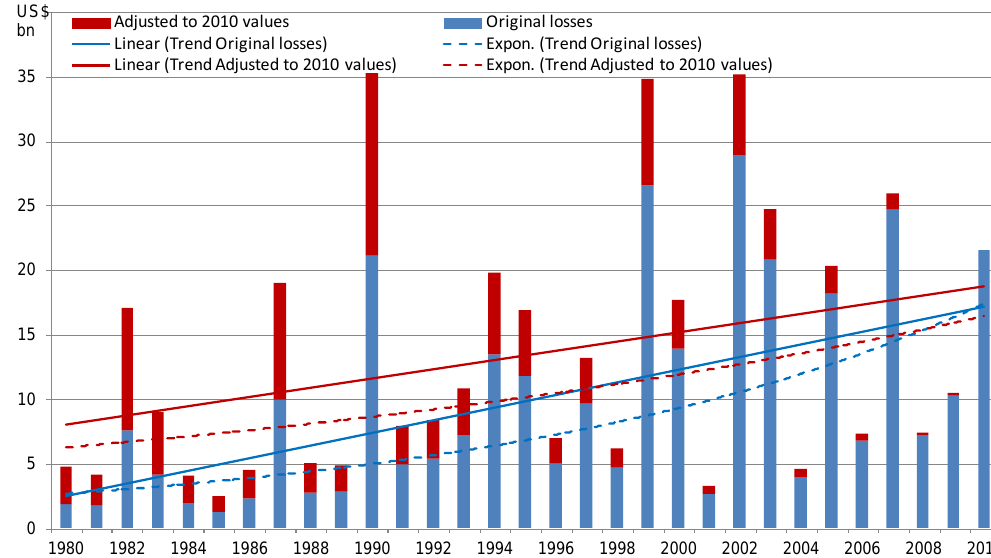
Fig. 4. Overall losses from weather disasters in Europe (1980–2010) in original and inflation-adjusted (2010) values. 3 high-intensity losses (i.e., high levels of damage per unit of area), but normally the affected area is comparatively